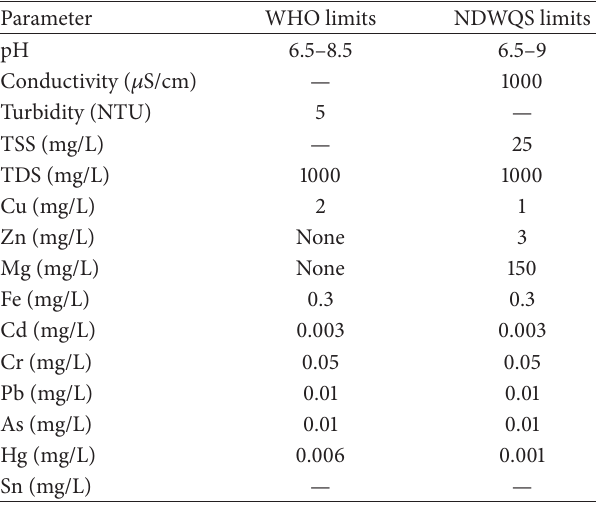
Table 2: The safe limits of WHO and NDWQS for determining drinking water